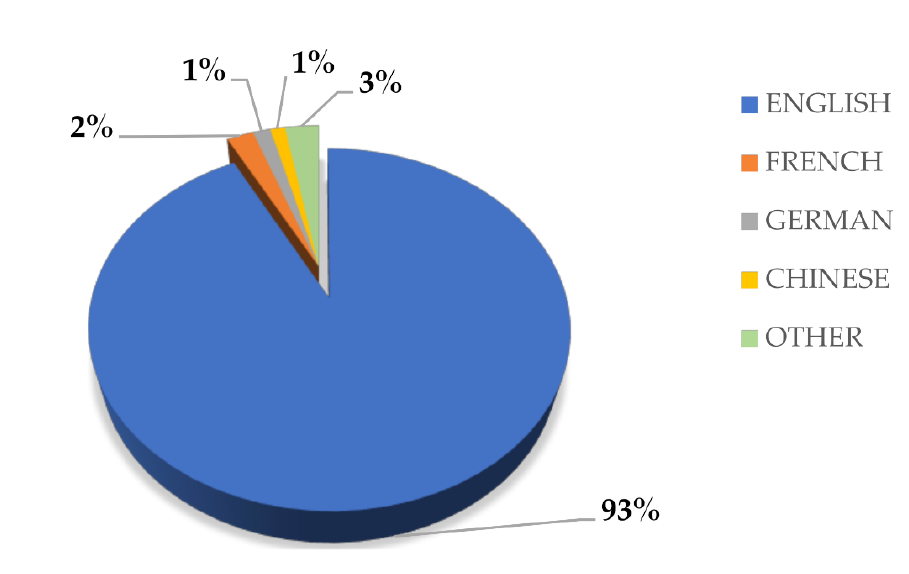
Figure 4. Languages used in the research documents on ozone in the plant